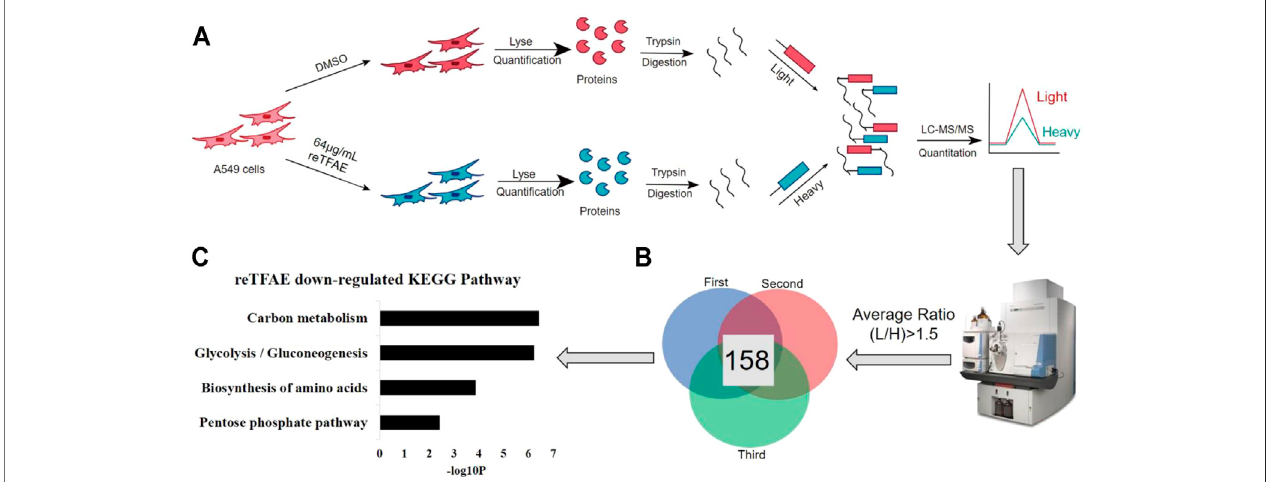
FIGURE 4 | reTFAE interfered with the glucose metabolism of A549 cells. (A) Overall scheme of In-solution dimethyl labeling experiment, the control or reTFAE groupwerelabeledwith “ light ” or “ heavy ” ,respectively. (B) Venndiagramshowingthe158proteinswithanaveragedratio > 1.5appearingtwiceintripleexperiments. (C) KEGG pathway analysis of the 158 proteins. p < 0.01 was the cutoff for displaying the